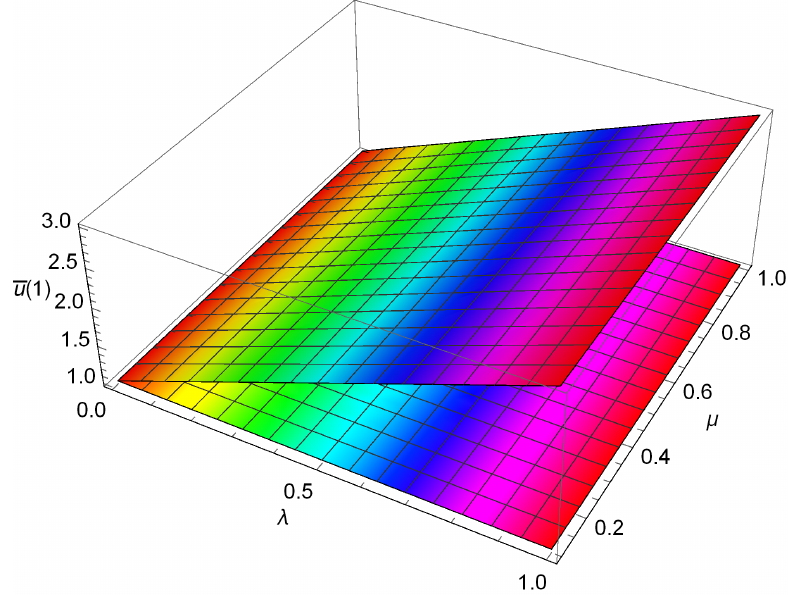
Figure 3. CF nano-rod with a concentrated load at the free end. 3D plot of the non-dimensional maximum axial displacement ¯ u ( 1 ) vs. the non-dimensional characteristic parameters λ and µ . The non-dimensional local maximum axial displacement ¯ u e ( 1 ) = 1 is the horizontal